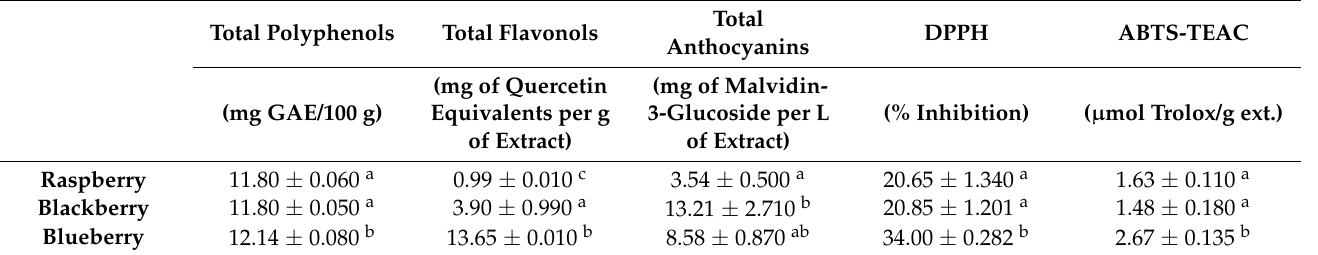
Table 1. Characterization of the antioxidant properties of the